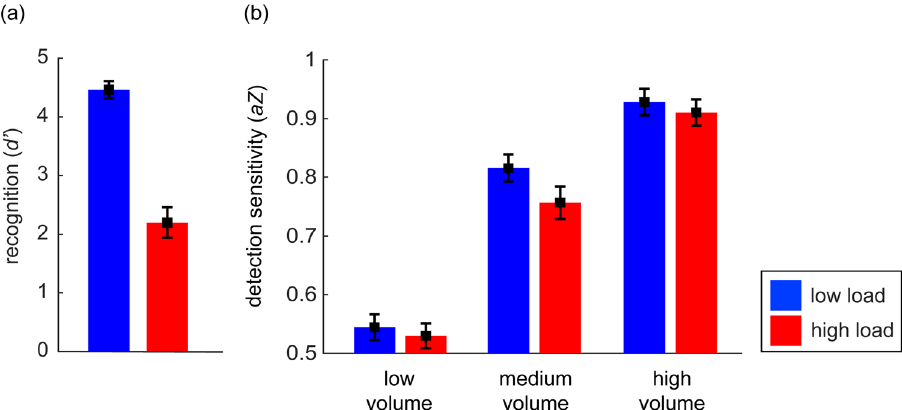
Figure 3. ( a ) Recognition ( d ′ ) in the working memory task for the two load conditions, and ( b ) detection